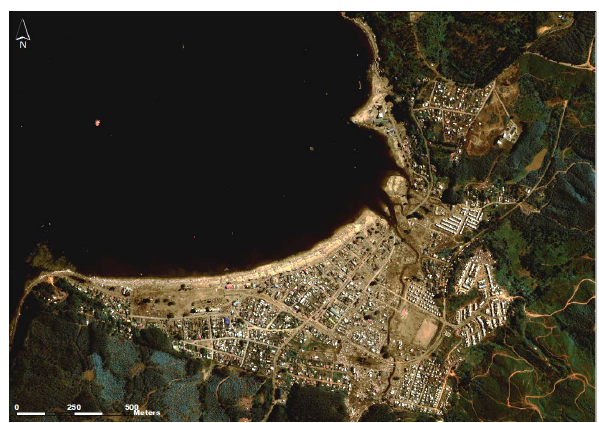
Fig. 4. Satellite image taken after the tsunami event in Dichato (Chile) – 10 March 2010.